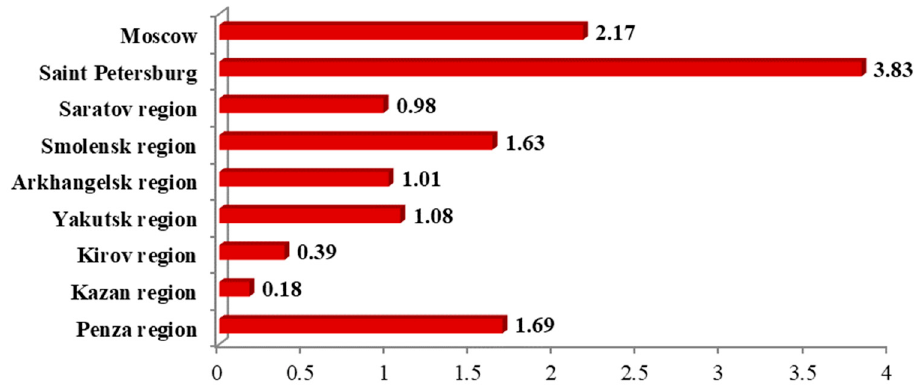
Figure 4. Total mortality because of SARS-CoV-2 per 1000 people at the time of the study. The highest lethality rates, defined as the ratio of deaths occurring because of SARS- CoV-2 to the total number of people affected by the disease during the pandemic period, were recorded in Saint Petersburg, Penza, and Smolensk regions ( p < 0.05). The minimum value of this indicator was observed in the Kirov region ( p < 0.05) (Figure 5).